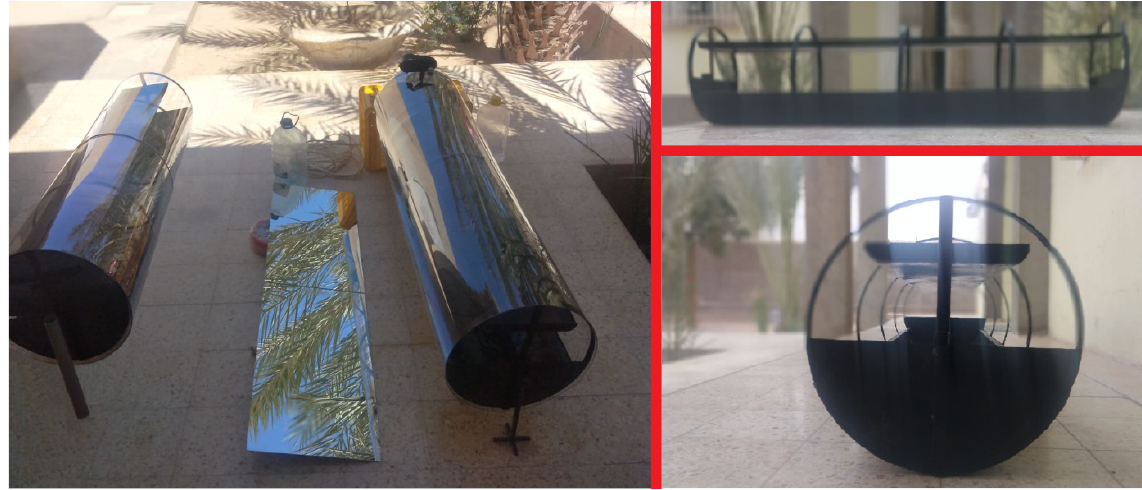
Figure 2. Real prototype of the novel solar still design.